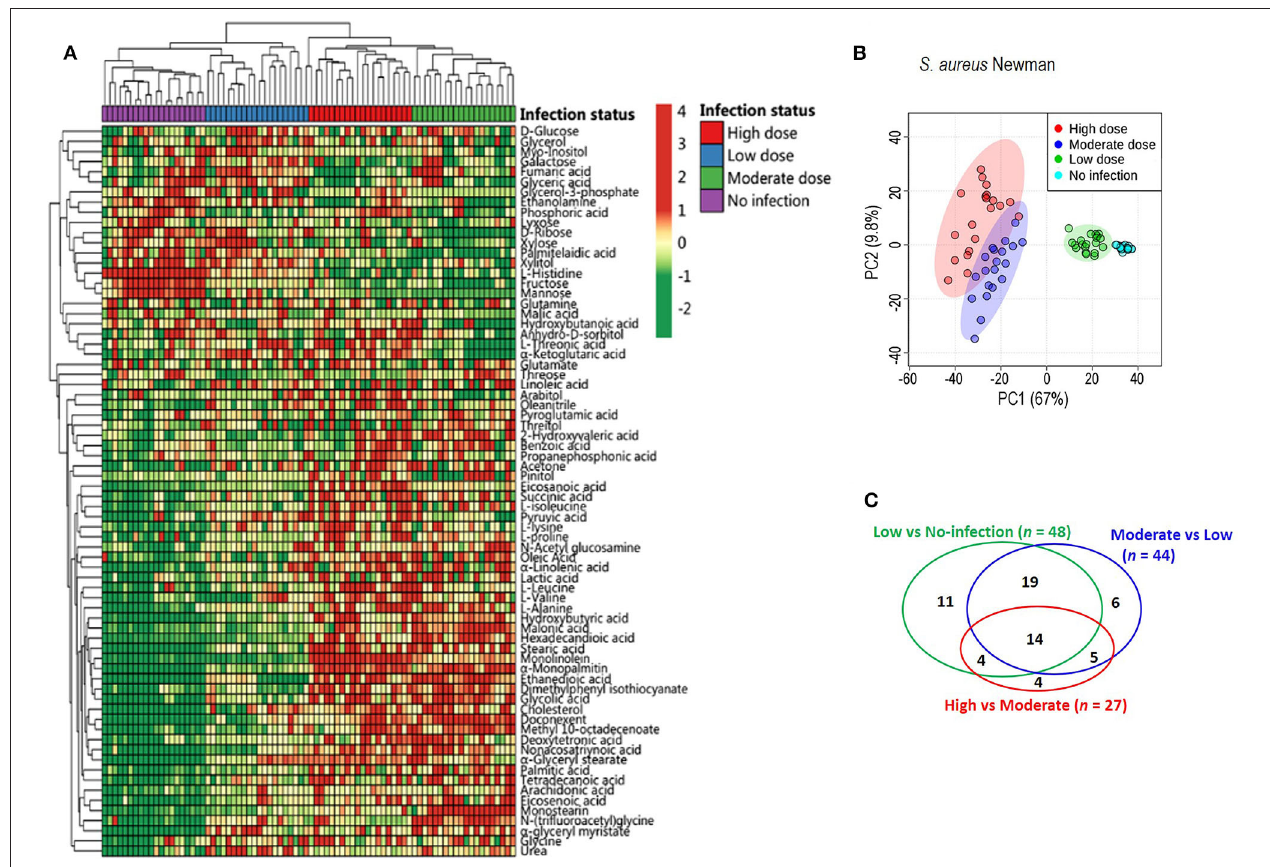
FIGURE 1 | Metabolic profiles of mouse sera injected with different doses of S. aureus Newman. (A) The heat map for relative abundances of differential metabolites in low, moderate, and high dose of S. aureus Newman strain compared with no-infection control ( n = 10, technical replicate = 2). Red and green indicated the increased and decreased of metabolite, respectively (see color scale). (B) Principal component analysis (PCA) of metabolomics data. Each dot showed a technical replicate for one sample. (C) Venn diagram showing the number of significant metabolites between pairwise comparison from no-infection group to high-dose